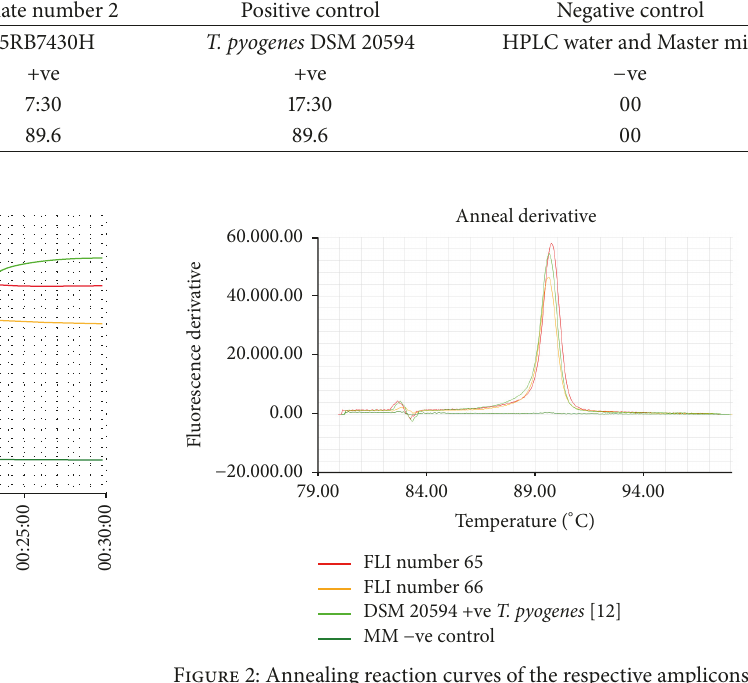
Figure 2: Annealing reaction curves of the respective